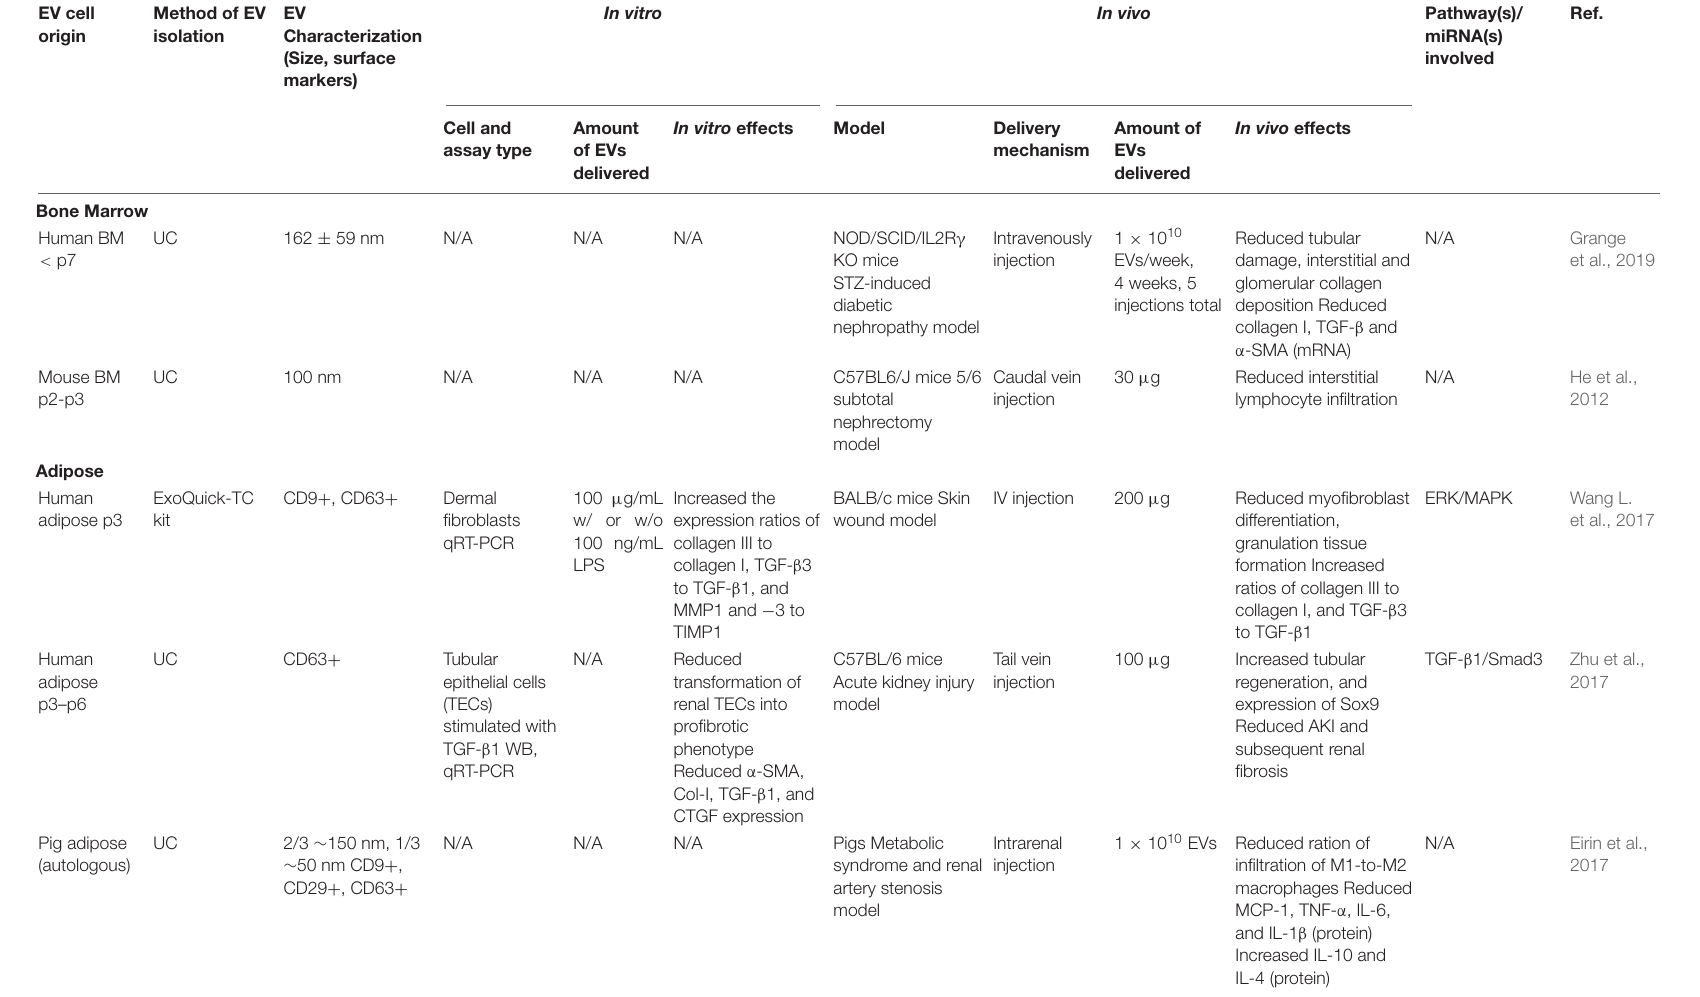
TABLE 4 | Preclinical studies employing BMMSC- and ADMSC-derived EVs to induce anti-fibrotic